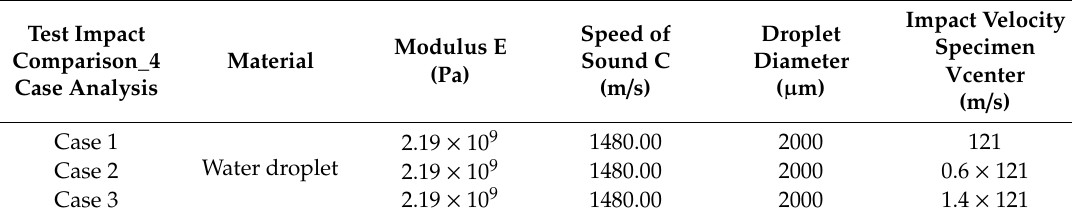
Table 6. Modelling input data for variation cases in droplet impact velocity and considering semi-infinite substrates, h s > 2d C s .